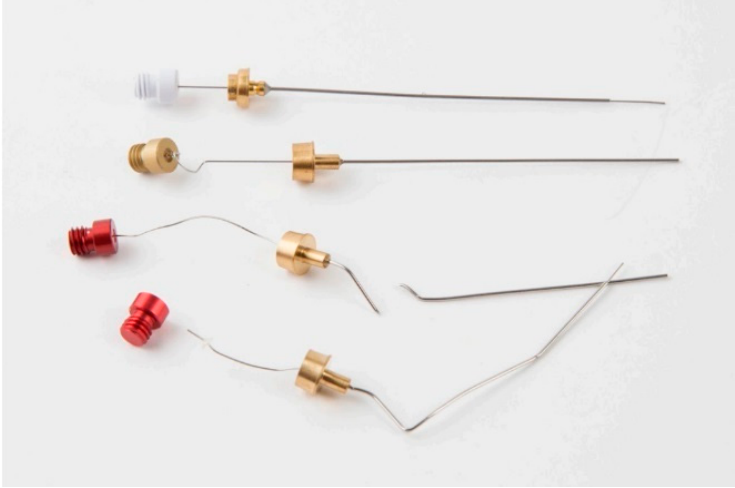
Figure 4. Mechanical failures common to traditional SPME fibers .